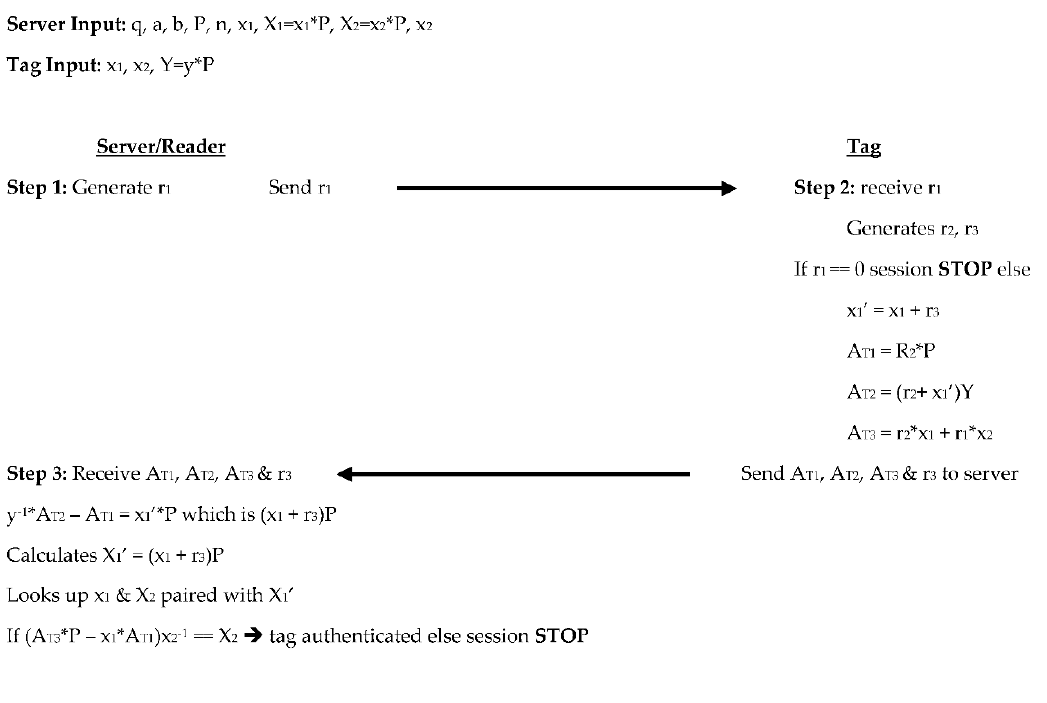
Figure 5. Authentication phases for Zhang et al. [13].